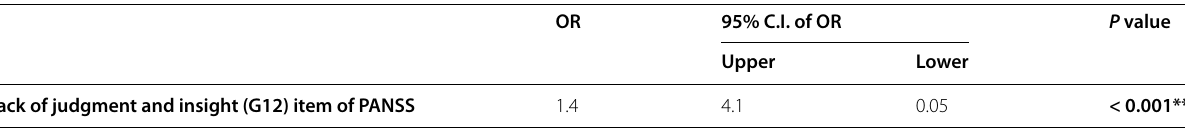
Table 5 Lack of judgment and insight predictive value of good outcome in the study sample